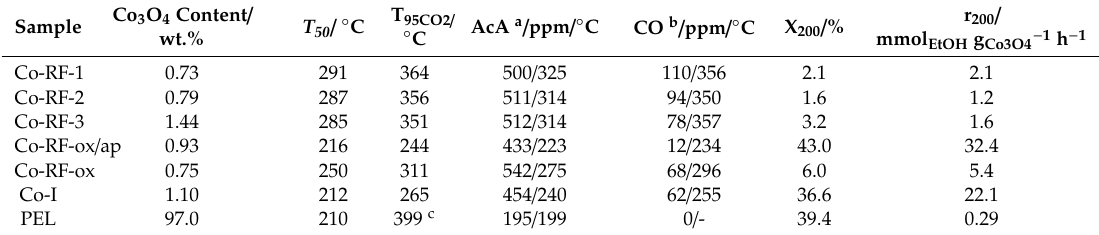
a Maximum concentration of acetaldehyde in the reaction mixture and corresponding reaction temperature. b Maximum concentration of carbon monoxide in the reaction mixture and corresponding reaction temperature. c 93% conversion of organic compounds.